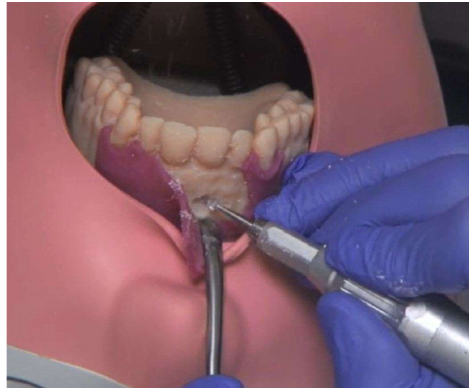
Figure 7. Osteotomy of the root tip.